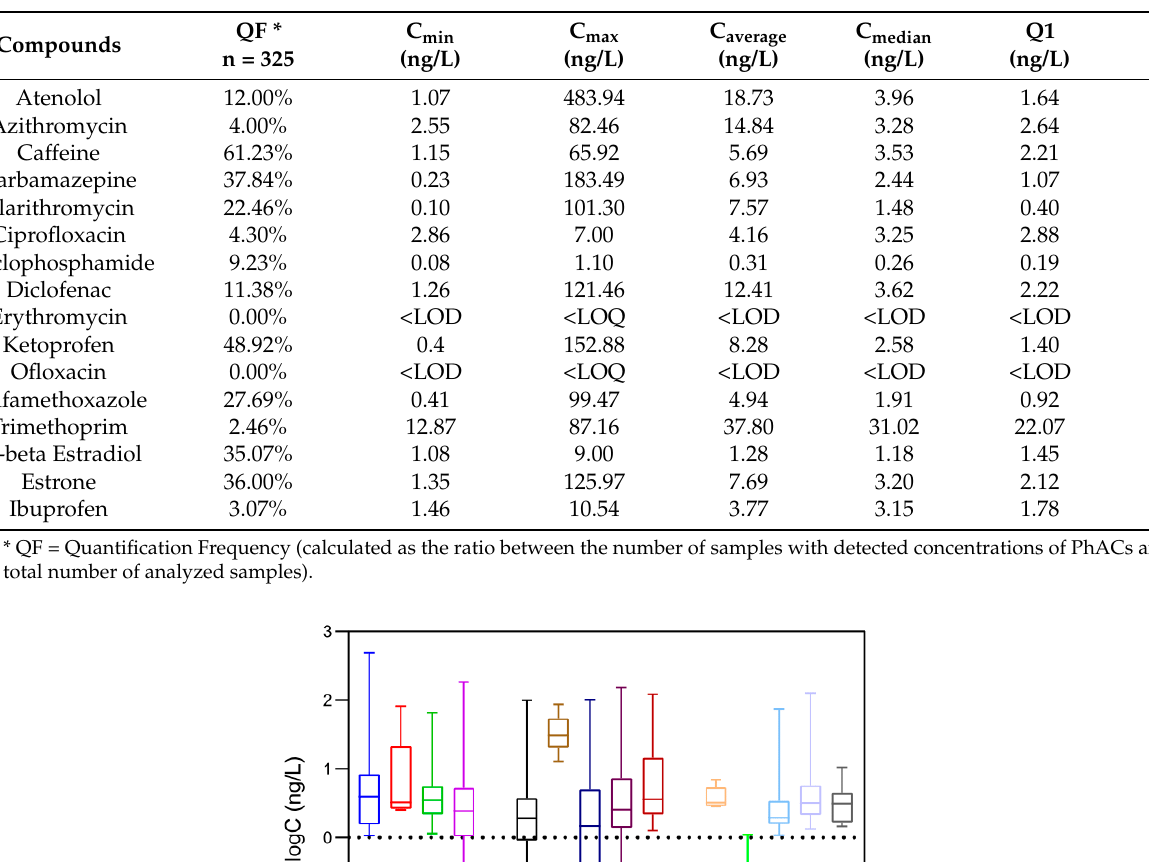
Table 2. Occurrence concentrations of target PhACs in the study area, without taking into account the non-detected.